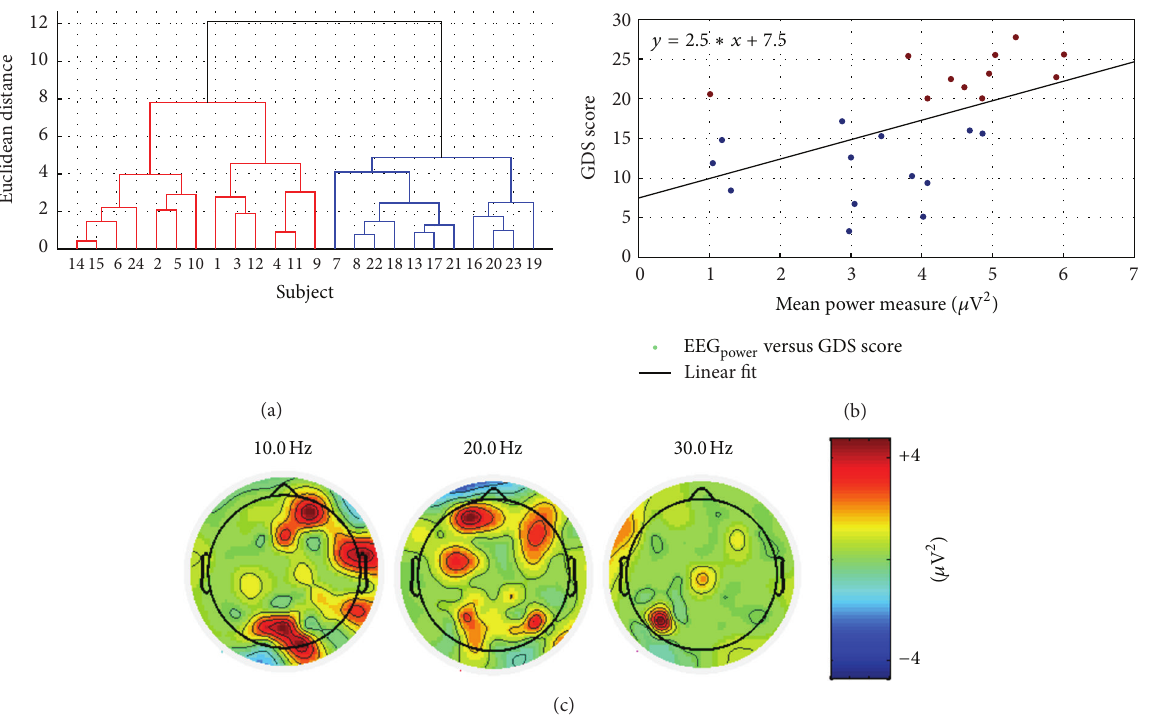
Figure 4: (a) Dendrogram plot of the hierarchical cluster tree from the data set—mean power measure at O1, O2, and P8 electrodes averaged over 4–30 Hz versus GDS scores. (b) Scatter plot between GDS scores and mean power measures where marker colors blue for “nondepressed” andbrownfor“depressed”showthetwohierarchicalclustersbasedontheEuclideandistance.(c)TopographicmapsofdifferenceEEGspectra at 10Hz, 20 Hz, and 30 Hz between “depressed” (GDS ≥ 15) and “nondepressed” (GDS < 15) QEEG